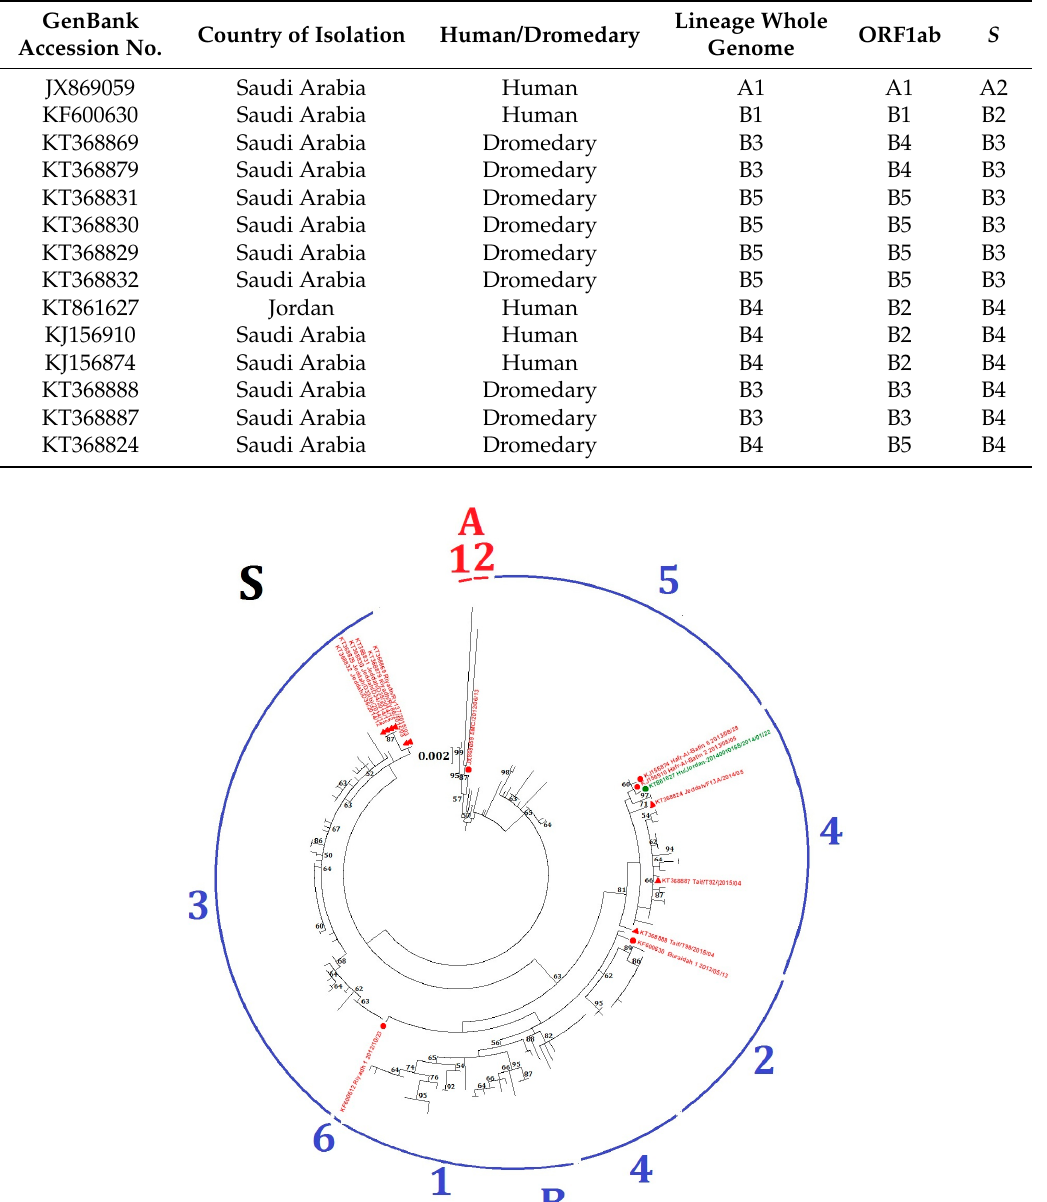
Figure 3. Maximum-likelihood phylogeny based on ORF1ab and S gene sequences of 219 MERS-CoV strains. GTR + G + I substitution model was selected for the ORF1ab and S gene trees. Bootstrap values in percentage are shown next to the branches. The scale bar indicates the number of nucleotide substitutions per site. Different colored letters and numbers represent different clades and lineages respectively: red letter, clade A; red number, lineages within clade A; blue letter, clade B; blue numbers, lineages within clade B. Selected MERS-CoV strains were annotated. MERS-CoVs from dromedaries are indicated in triangles. MERS-CoVs from homo sapiens are indicated in circles. The 15 MERS-CoV strains with potential recombination detected in the present study are colored: red, Saudi Arabia; green, Jordan.